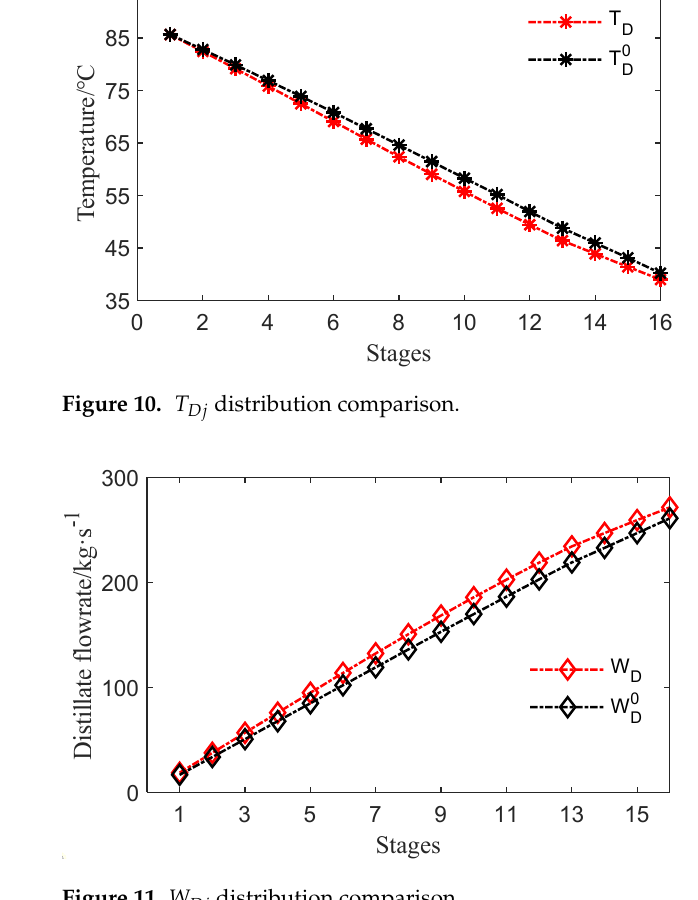
T distribution comparison. Figure 9. Bj